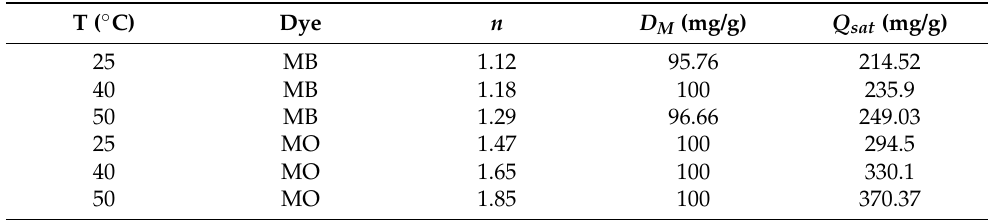
Table 1. Steric parameters of the double layer model for the adsorption of MB and MO on the Rt/BC